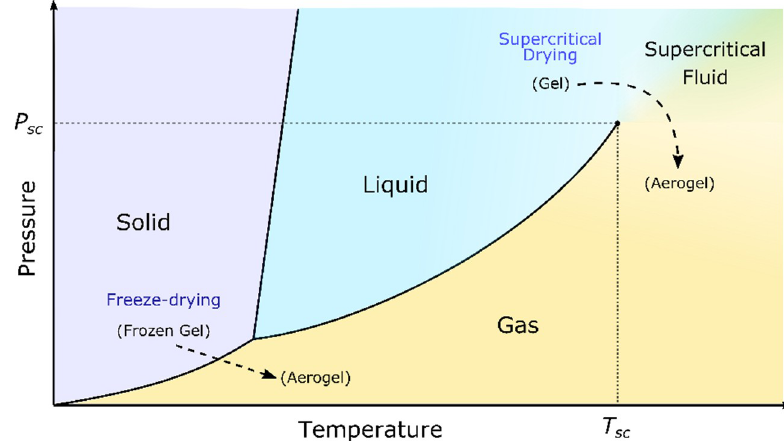
Figure 2. A typical phase diagram for pure compounds. Two methods are shown for the gel to aerogel transition, indicated by I → II. The solid-gas transition depicts the transition from a frozen gel (I) to the dried porous gel (II) during freeze-drying (Section 2.2). The transition from a liquid to gas during supercritical drying requires a rise in temperature and pressure (curved arrow from I → II) to avoid crossing the liquid-gas phase boundary (Section 2.1). This pass into the supercritical region eliminates surface tension and capillary forces.